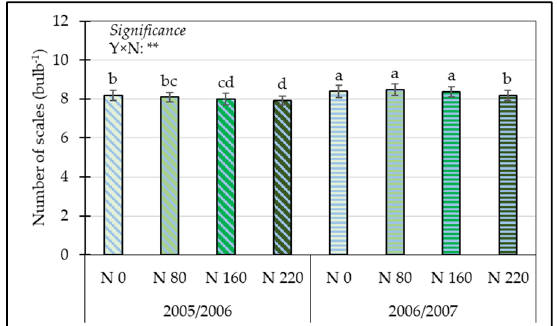
Figure 2 . Influence of the interaction Y × N on the number of scales. Means with the same letter are not significantly different at p ≤ 0.05 according to Tukey’s test. Bars represent the standard error. ** = significant at p ≤ 0.01; Y = Year; N = Nitrogen.